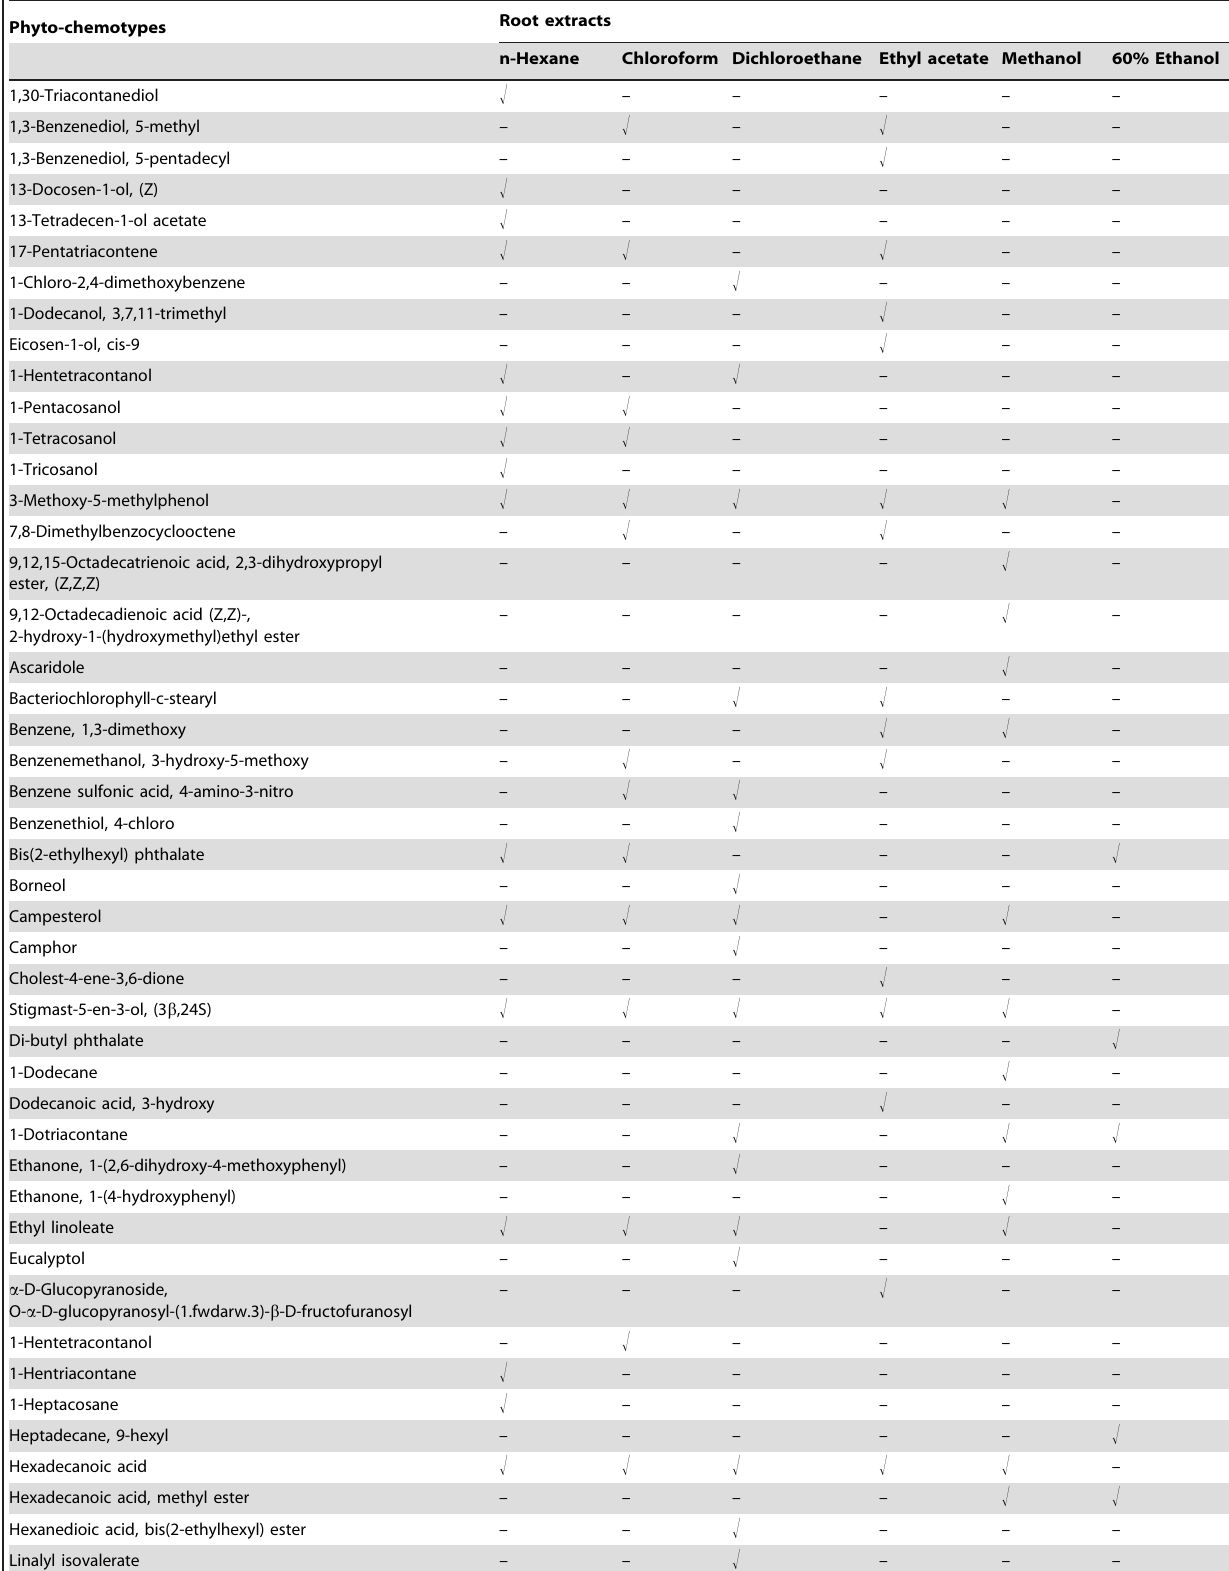
Table 7. Distribution of phyto-chemotypes in different root extracts of R. imbricatea